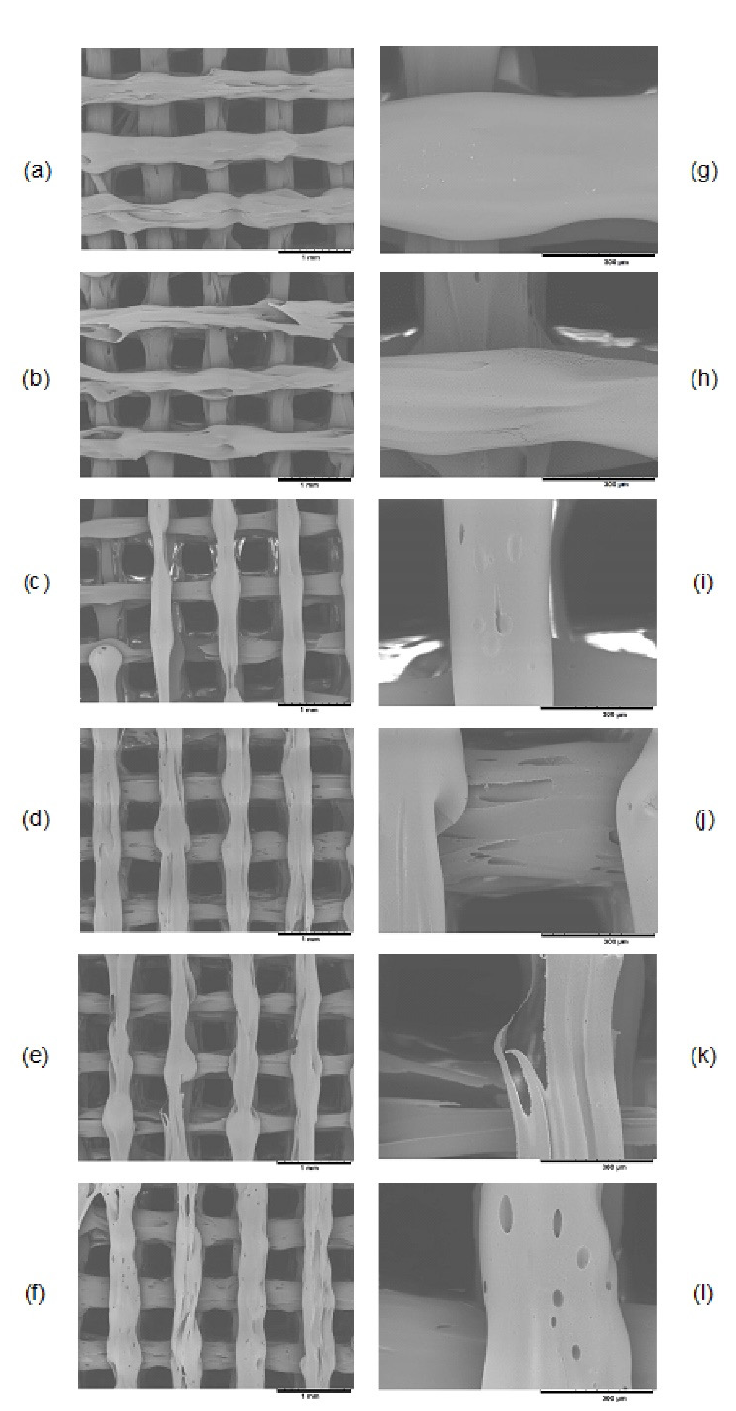
Figure 4. SEM images (scale bar: 1 mm) of the 3D-printed PLA scaffolds analyzed: ( a ) non-degraded PLA; ( b ) PLA; ( c ) PLA plasma; ( d ) PLA aloe vera pH 3; ( e ) PLA aloe vera pH 4 and ( f ) PLA aloe vera pH 5. Additionally, SEM images with higher magnification (scale bar: 300 µm) are shown for ( g ) non-degraded PLA; ( h ) PLA; ( i ) PLA plasma; ( j ) PLA aloe vera pH 3; ( k ) PLA aloe vera pH 4 and ( l ) PLA aloe vera pH 5.